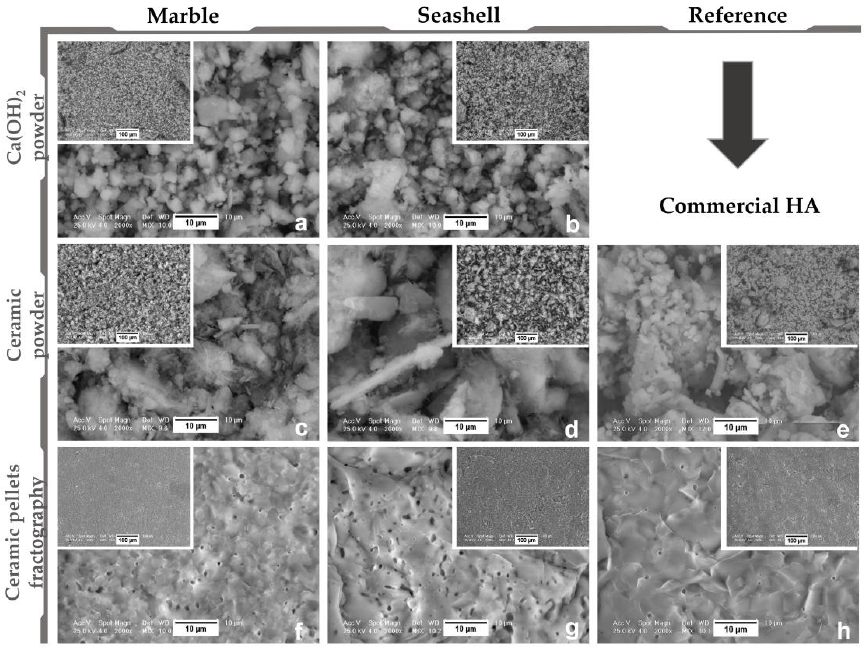
Figure 1. Representative micrographs for marble, seashell and reference material derived products: Table 1. Chemical composition of naturally derived calcium phosphate based-materials: (A) post Synthesis and (B) post Thermal Treatment and compressive strength of sintered pellets. Sample